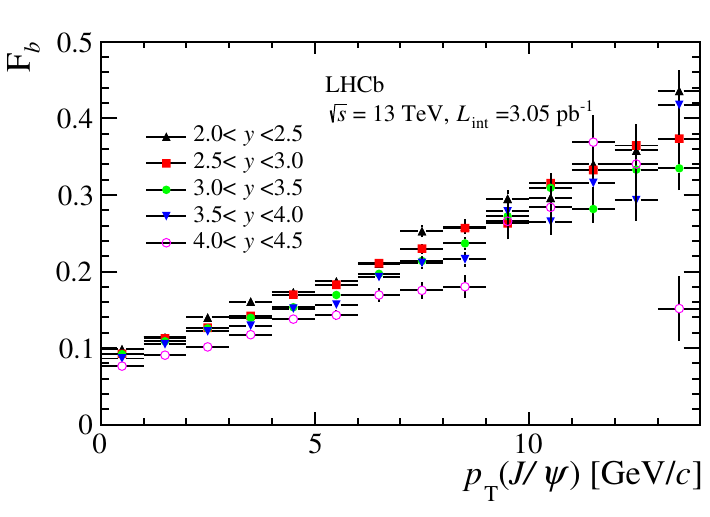
Figure 4 . Fractions of J= -from- b mesons in bins of J= p T and y . Statistical and systematic uncertainties are added in quadrature.